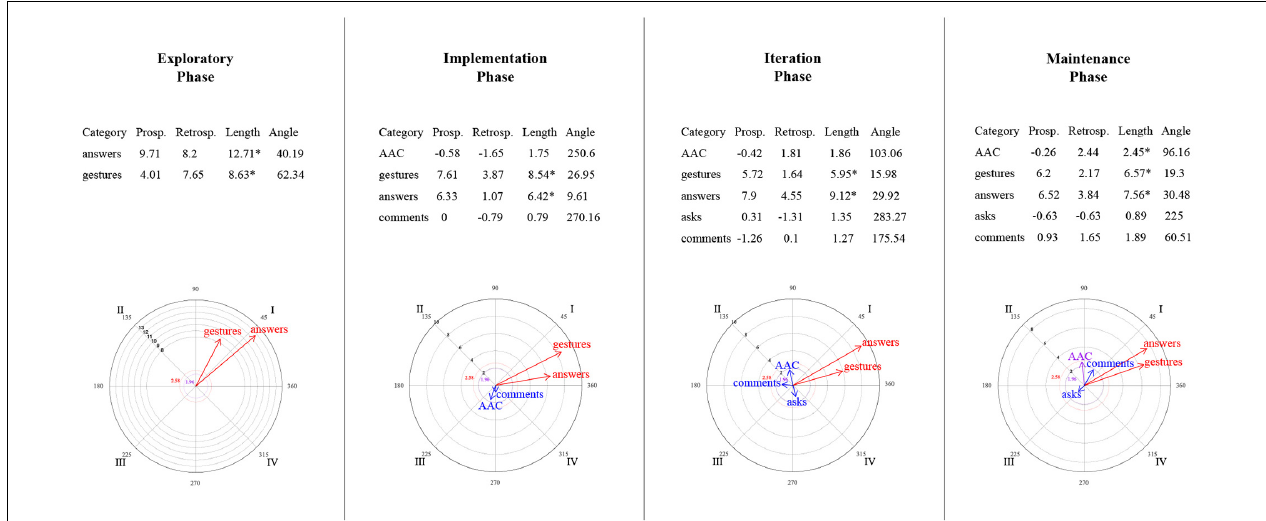
FIGURE 9 | Vectors corresponding to the mother’s emotion-related closed-ended question as focal behavior, and the child’s emotion-related communicative turns [answers, comments, asks] and methods of expression [AAC, conventional gestures] as conditional behaviors.